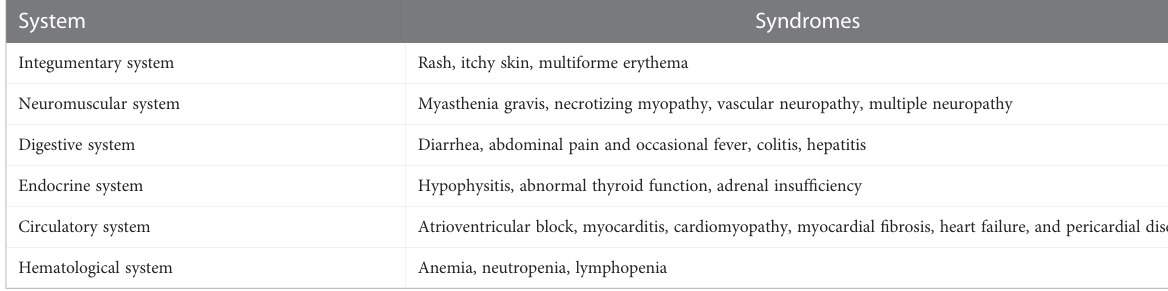
TABLE 2 Immune-related adverse events related to the immune system caused by anti-PD-1/PD-L1